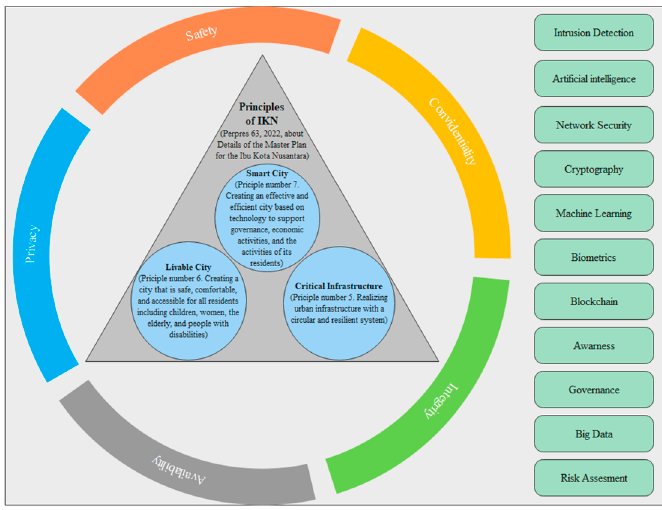
Figure 4. Proposed